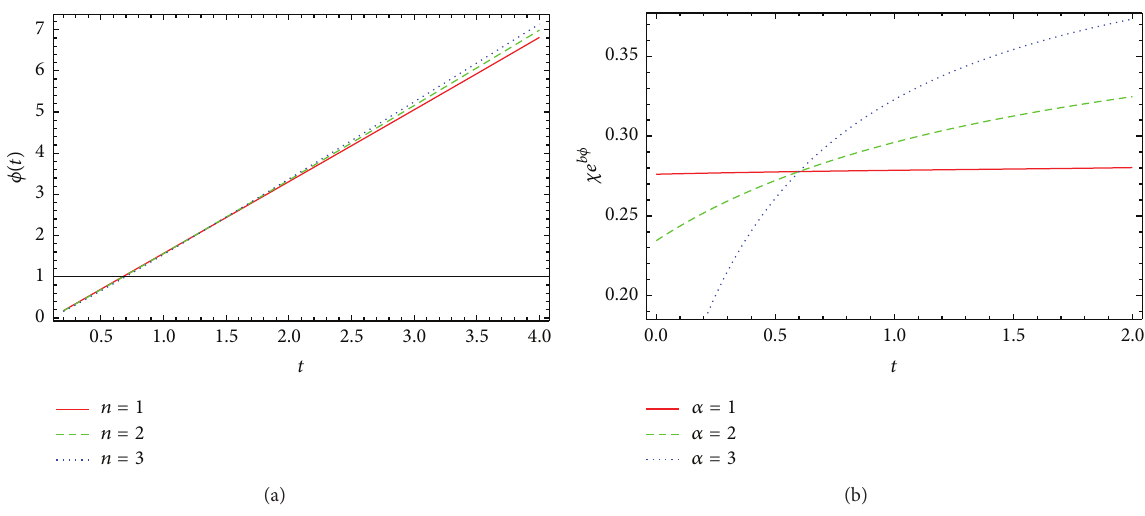
Figure 7: Plots of 𝑓(𝑅,∇𝑅) dilaton scalar field model (a) 𝜙 versus cosmic time 𝑡 and (b) kinetic energy term 𝜒𝑒 𝑏𝜙 versus 𝑡 for 𝑛 = 1 (red), 𝑛 = 2 (green), and 𝑛 = 3 (blue).